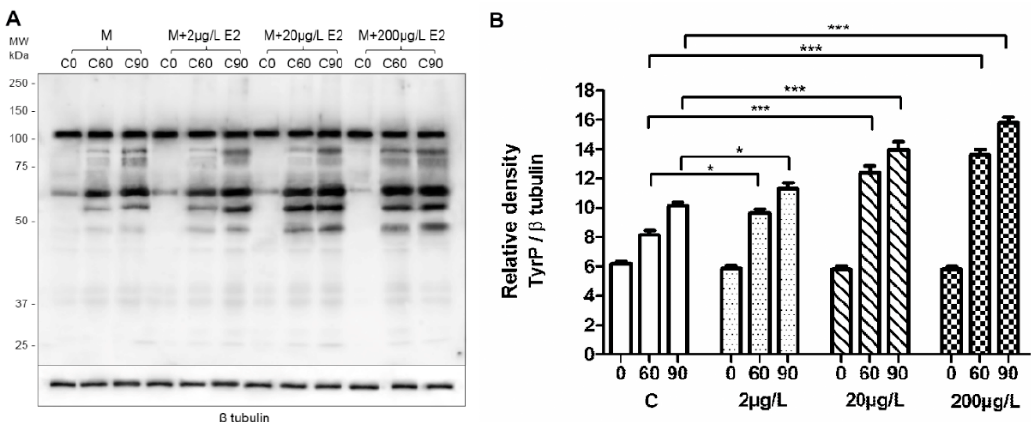
Figure 3. Time-dependent sperm protein TyrP in presence of estradiol (E2) under capacitating conditions as assessed by Western blot analysis and relative densitometry. ( A ) Control samples: sperm capacitating in commercial M2 medium (M); M + E2: the medium enriched by E2 in different concentrations (2, 20, and 200 µ g/L). In contrast with freshly released epididymal sperm (t0), protein TyrP increased during sperm capacitation (t60, t90) with a maximum value at 90 min (t90). The protein TyrP was stronger when E2 was present. Increasing concentrations of E2 lead to stronger protein TyrP. β -tubulin was used as the loading control. The samples contained a protein equivalent of 106 cells. Five experiments per group were prepared; the representative results are shown. ( B ) Densitometry analysis of TyrP protein levels in sperm of control samples and sperm incubated in M2 medium enriched by E2. The densitometry analysis indicates relative levels of TyrP revealed a time- dependent and significant increase. Error bars indicate the SD. The statistical significance of the differences among protein TyrP abundances in different groups is indicated by asterisks (* p ˂ 0.05, *** p ≤ 0.001).